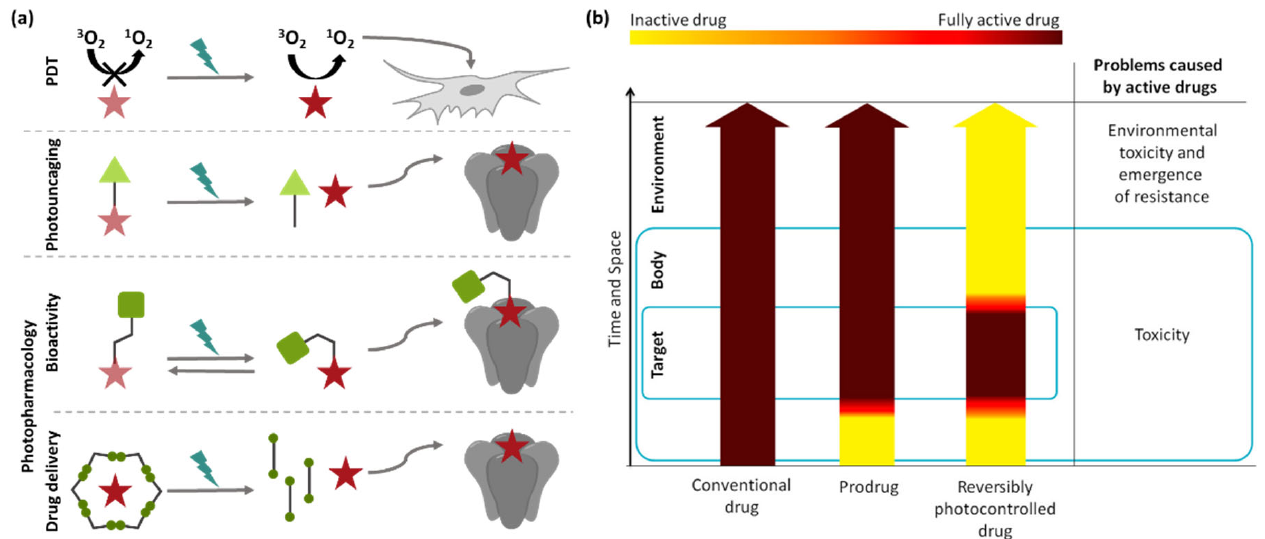
Figure 2. Basic principles of light-dependent pharmacology. ( a ) In photodynamic therapy (PDT), chromophores are applied that generate highly toxic, non-specific singlet oxygen ( 1 O 2 ) upon relax- ation from a light-induced excited state. Irreversible photouncaging uses photoresponsive prodrugs that release active drugs through light-induced cleavage of a covalent bond and photopharmacology uses photoswitchable drugs that can be reversibly activated with light. Additionally, photoswitchable drug delivery systems enabling light-triggered drug release have been developed. ( b ) Comparison of drug activity over time and space during treatment with conventional drugs, photouncagable prodrugs and reversibly photoswitchable drugs. Photopharmacology aims to prevent adverse effect and environmental buildup by enabling light-triggered activation selectively at the target site [16,17]. Reprinted with permission from the ref. [16]. Copyrights (2014) American Chemical Society.